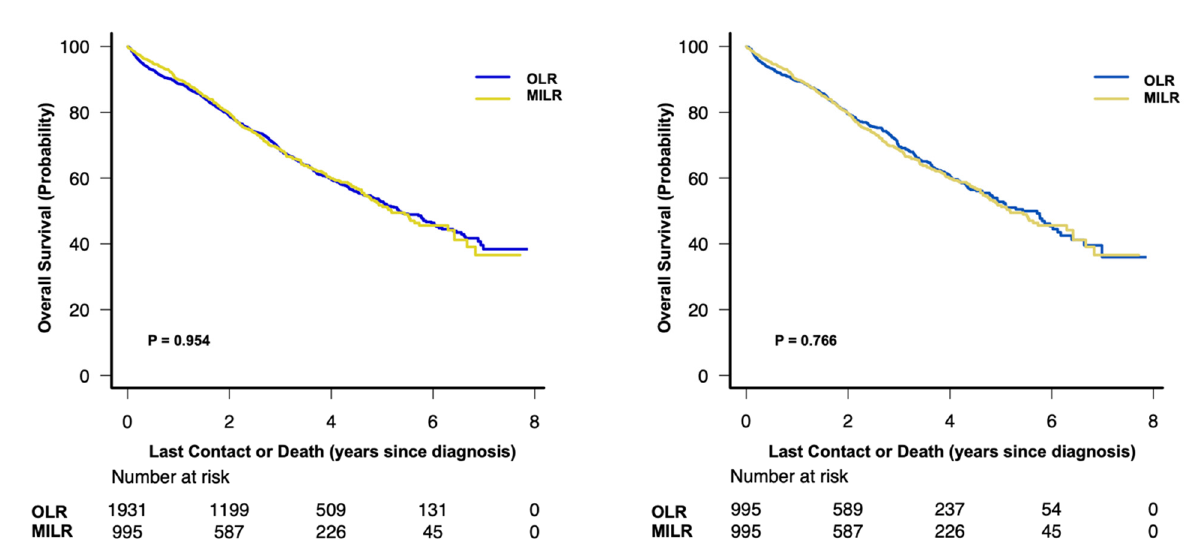
Figure 3. Overall survival in (A) the unmatched and (B) the propensity score matched study cohort with stage I or II hepatocellular carcinoma (log-rank test). MILR, minimally invasive liver resection; OLR, open liver resection.